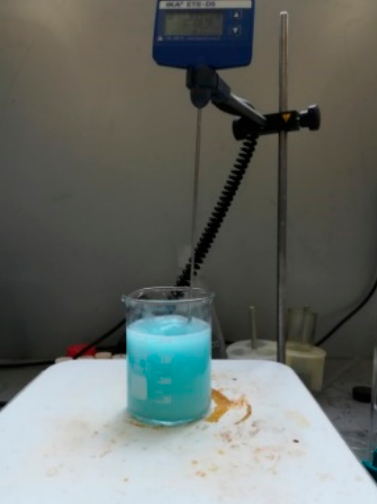
Figure 7. The reaction mixture employed for obtaining MUF microcapsules with embedded ENB healing agent.